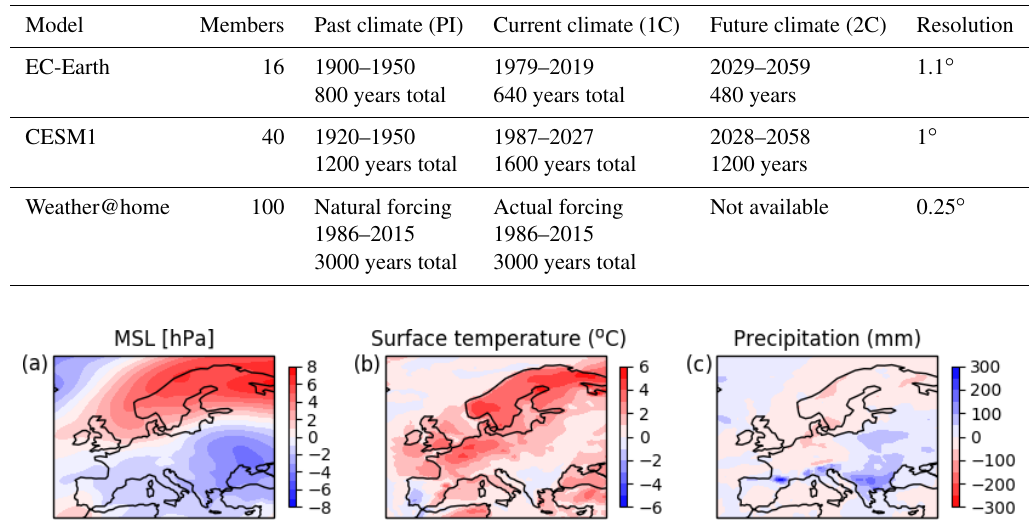
Table 1. Overview of the climate models and the years used to represent the different climate states.